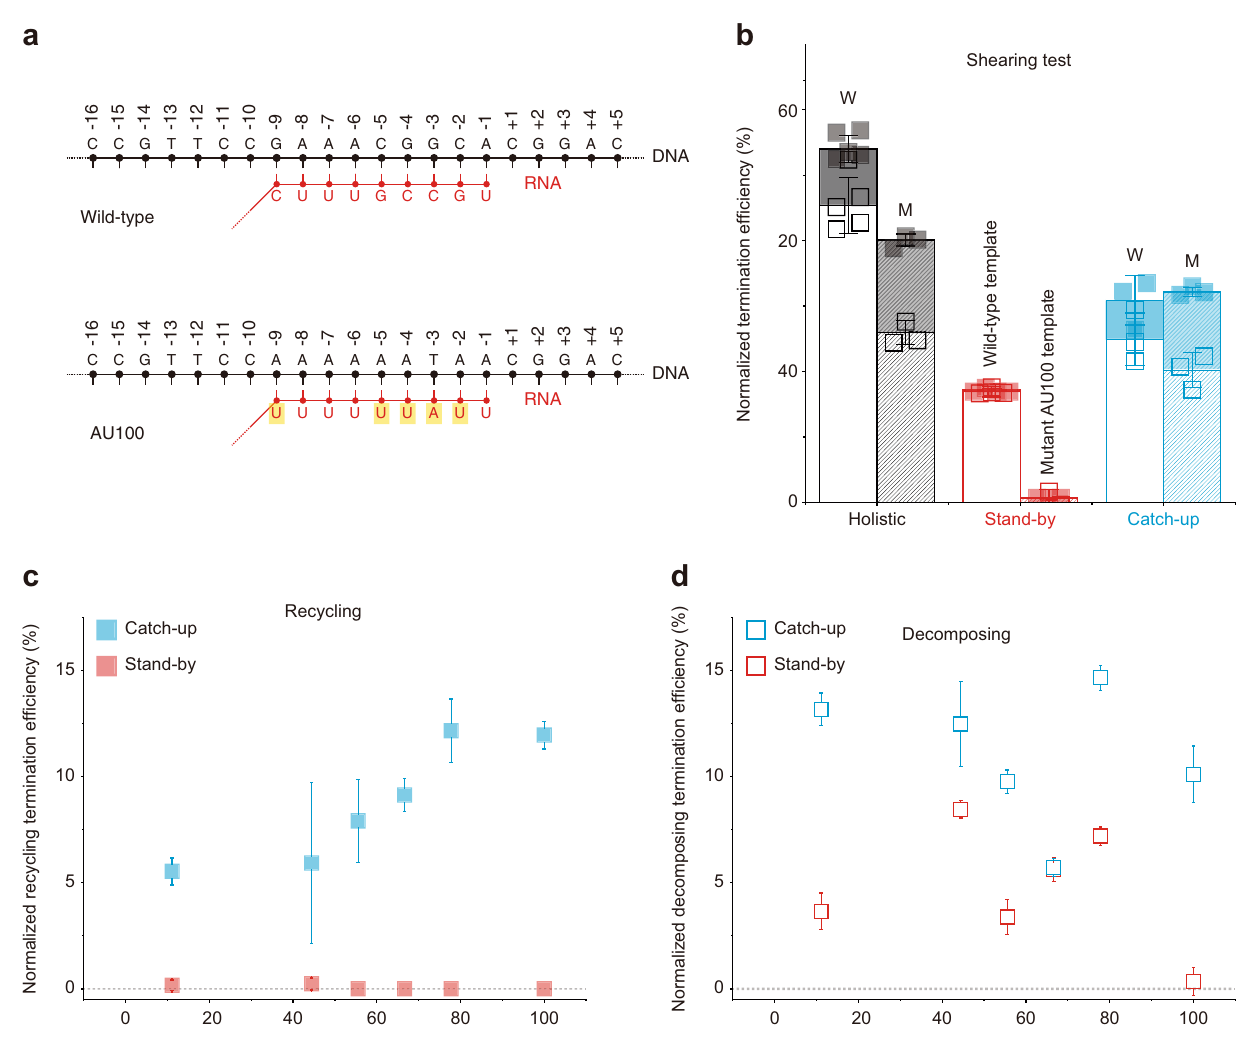
Fig. 5 RNA shearing resulting only in RNAP recycling on DNA. For RNA shearing tests, comparisons were made among six templates producing RNA·DNA hybrids with varying AU contents. ρ -dependent TEs ( = raw TE — background TE) of recycling (solid) and decomposing (open) were measured in holistic (black), stand-by (red), and catch-up (cyan) assays and normalized to the maximum of 100% by dividing with (1 — background TE). a Putative RNA·DNA hybrids formed at the termination site. The AU content is 44% in the wild-type mgtA and 100% in AU100 mutant. b Augment of recycling termination by hybrid weakening in AU100. Normalized ρ -dependent TEs are compared between the wild-type (W) and AU100 (M). c Positive correlation of recycling termination with hybrid instability. Normalized recycling TEs in the y -axis are plotted against the AU content in the x -axis. d No correlation of decomposing TE with hybrid instability. Normalized decomposing TEs in the y -axis are plotted against the AU content in the x -axis. Error bar represents the standard deviation of the mean from n ≥ 3 independent experiments. The numbers of analyzed molecules for ( c ) and ( d ) are in Supplementary Table 2. Source Data fi le includes the data for ( c ) and ( d